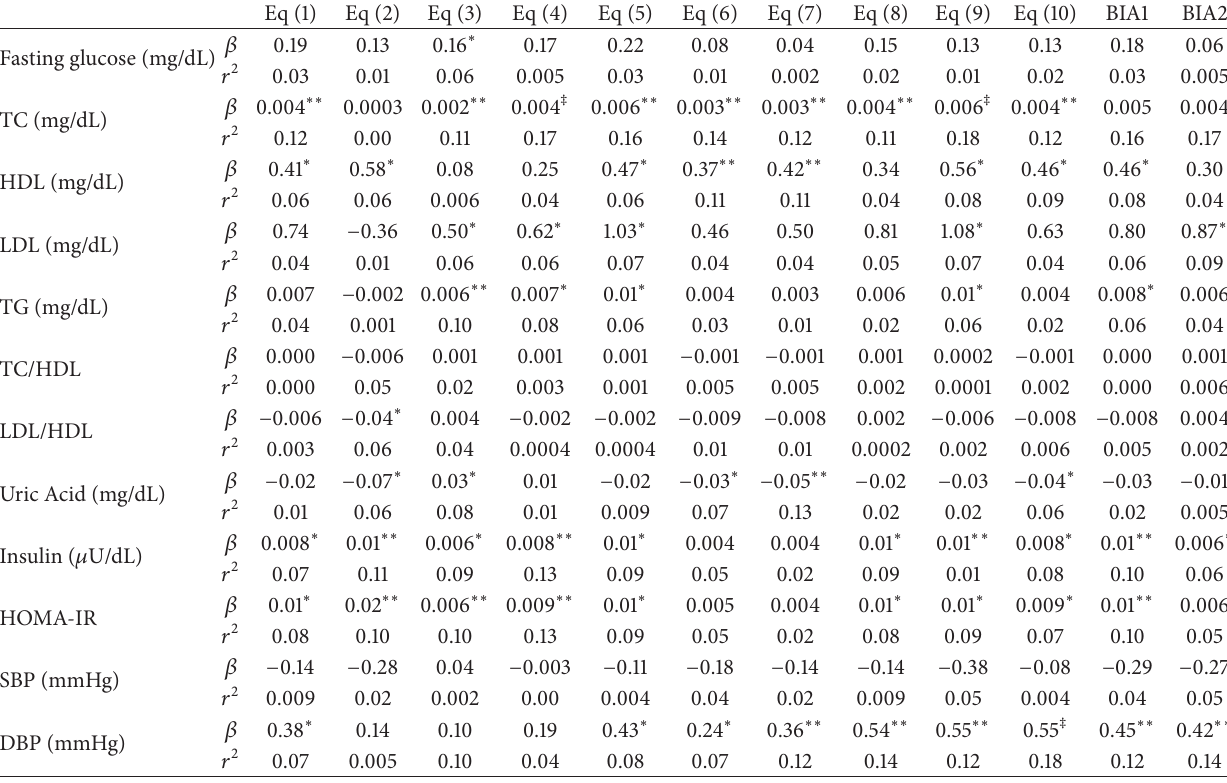
Table 5: Simple linear regression coefficient ( 𝛽 ) and coefficient of determination ( 𝑟 2 ) of the relationship between percentage of body fat and biochemical and clinical parameters in overweight adolescents (G2) (Vic¸osa, Minas Gerais, Brazil (2010)).